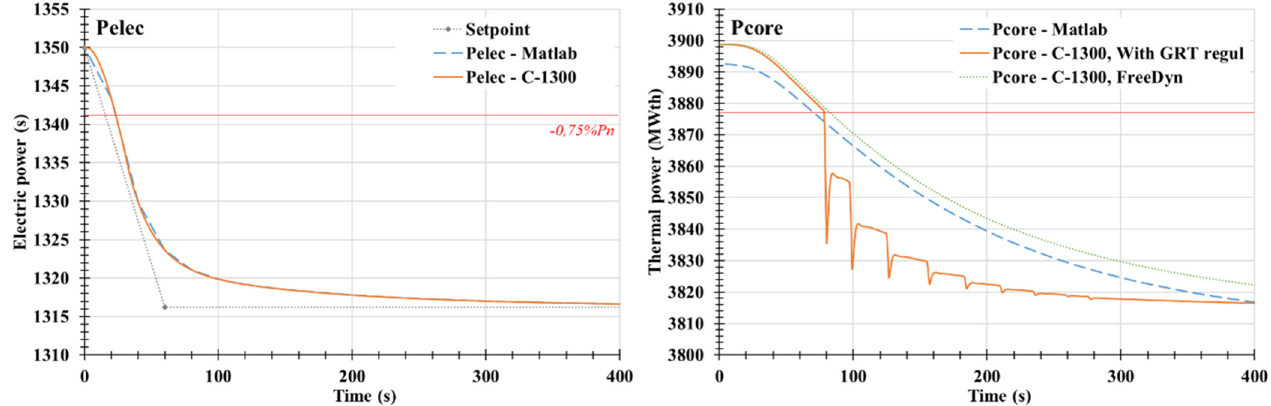
Fig. 9. Comparison of electrical and thermal power for the grid-following validation